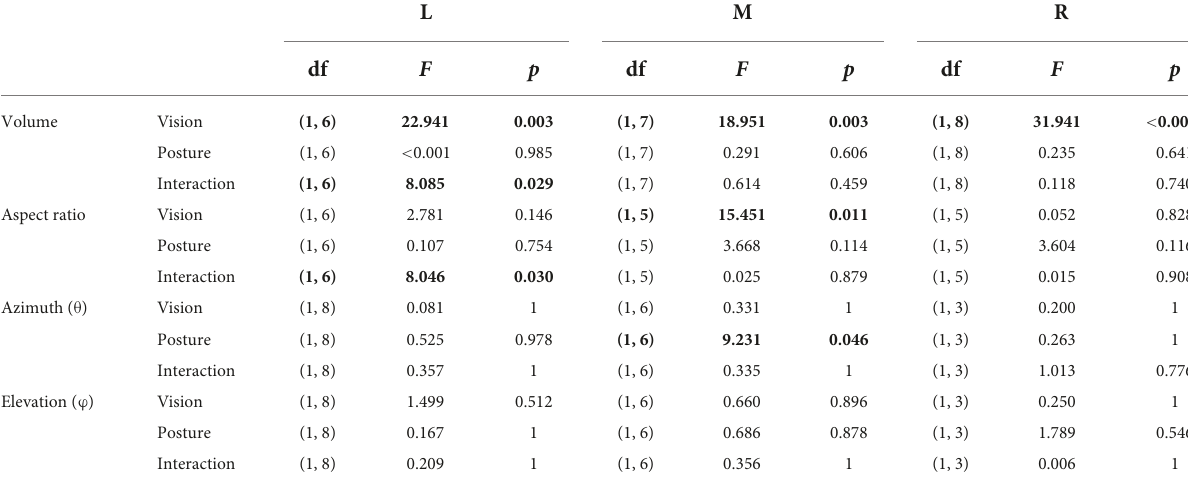
TABLE 1 Two factor repeated measures ANOVA results for the effects of initial arm and visual condition on ellipsoid volumes, aspect ratios, and orientations (azimuth, elevation). L